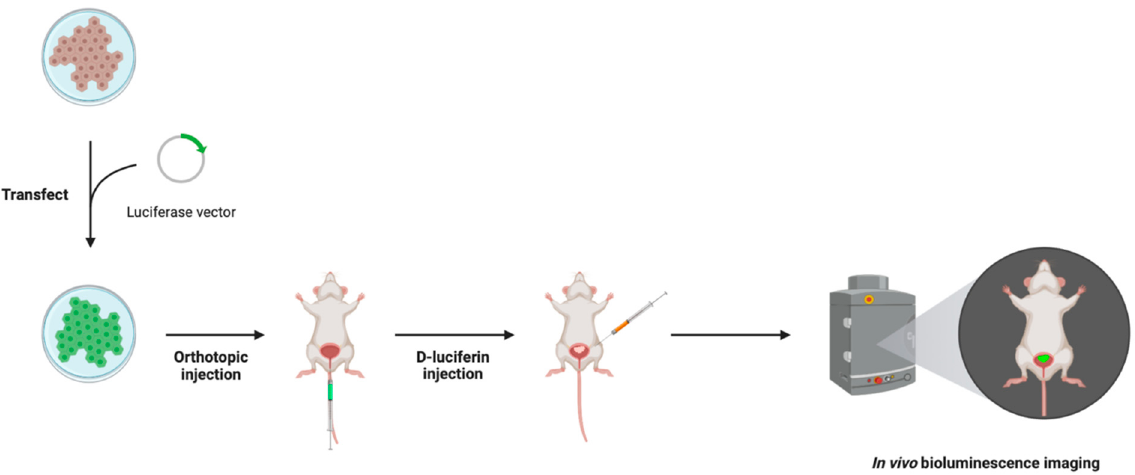
Figure 1. Bioluminescence imaging (BLI) method in an intravesical murine model of BCa, where a BCa cell line is transfected with a luciferase vector that is subsequently inoculated into the bladder wall of the murine model. The D-luciferin substrate is administered via intravascular or